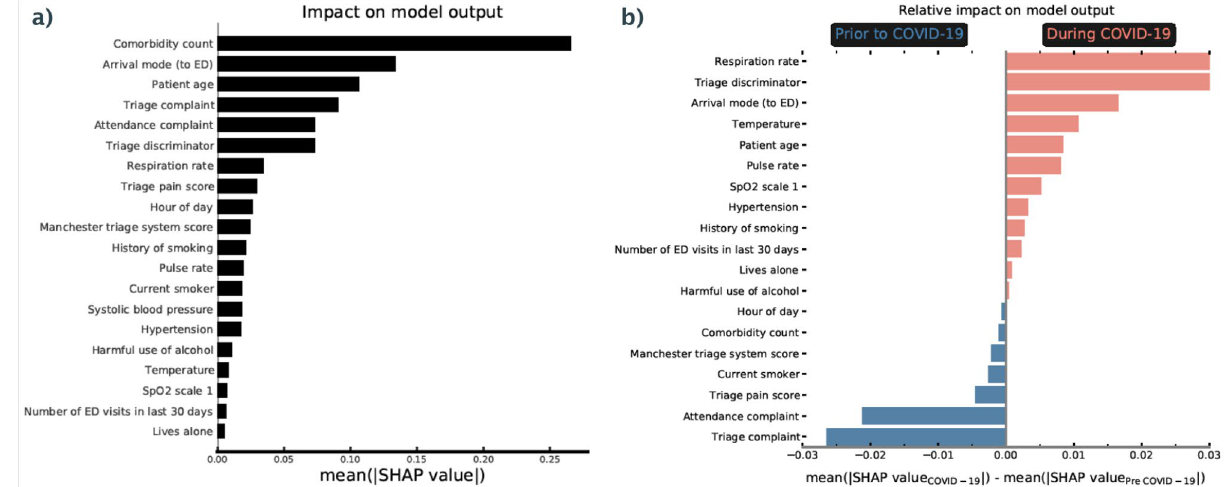
Figure 6. Importance ranking of input features for predicting admission risk. ( a ) Average (absolute) SHAP value for attendance features over all patients (both pre and during COVID). A higher value corresponds to a more important feature in decision making (i.e. predictive of admission risk). ( b ) Relative importance ranking of input features for predicting admission risk in COVID-19. Average (absolute) SHAP value for attendance features during COVID-19 relative to pre COVID-19 values. A higher (lower) value corresponds to a more important feature in decision making during (pre)